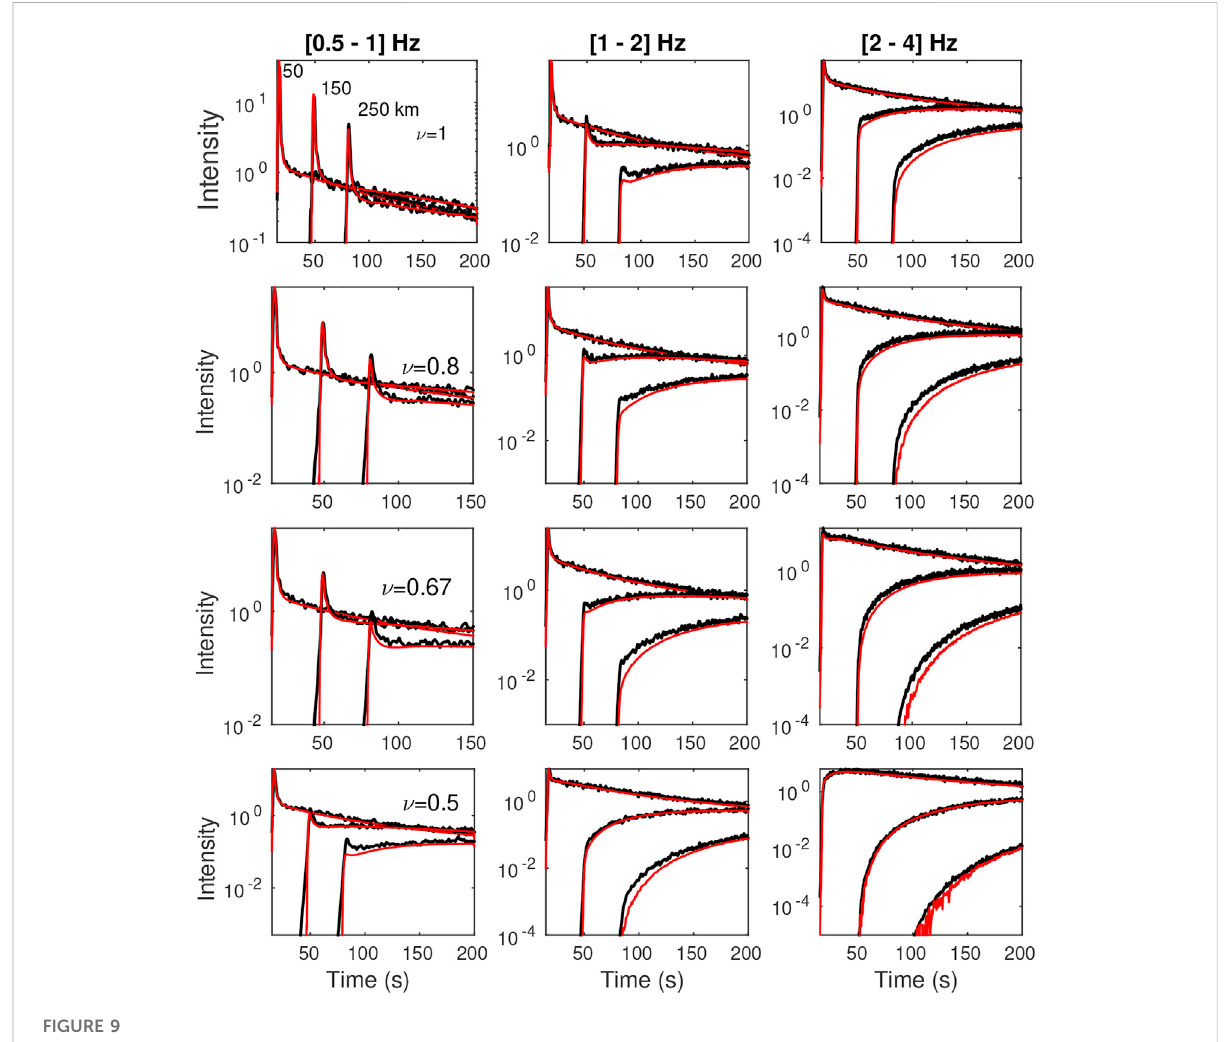
FIGURE 9 Same as Figure 8 for cases ε =